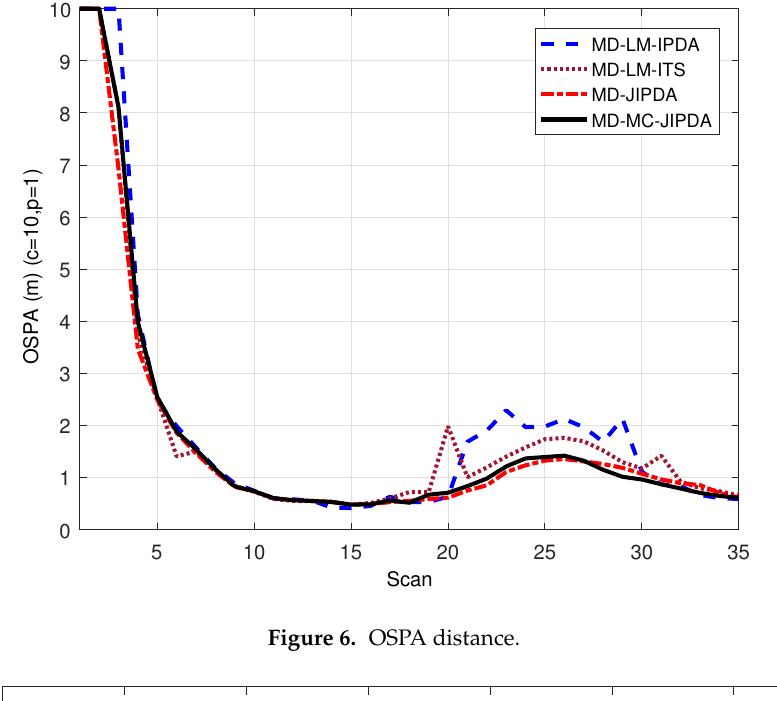
Figure 6. OSPA distance.